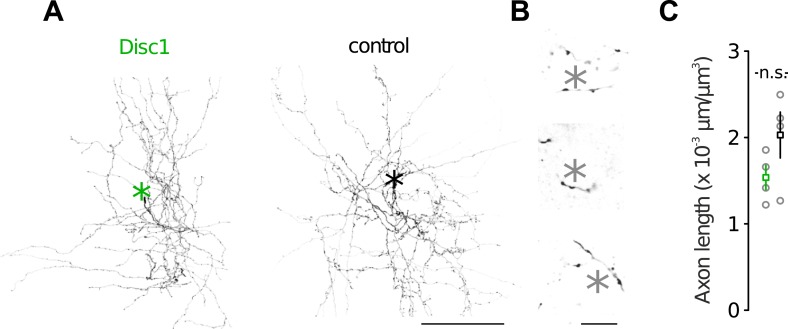
Morphological characteristics of FS-INs.(A) Axon reconstructions of FS-INs revealed dense axonal plexus. Asterisks mark som position (not shown). (B) FS-INs form perisomatic boutons on their target cells. Asterisks indicate soma positions of putative PCs. This example is depicted from a control mouse. (C) Disc1 and control FS-INs had similar total axon lengths. Data are mean ± SEM. n = 4 cells each group.